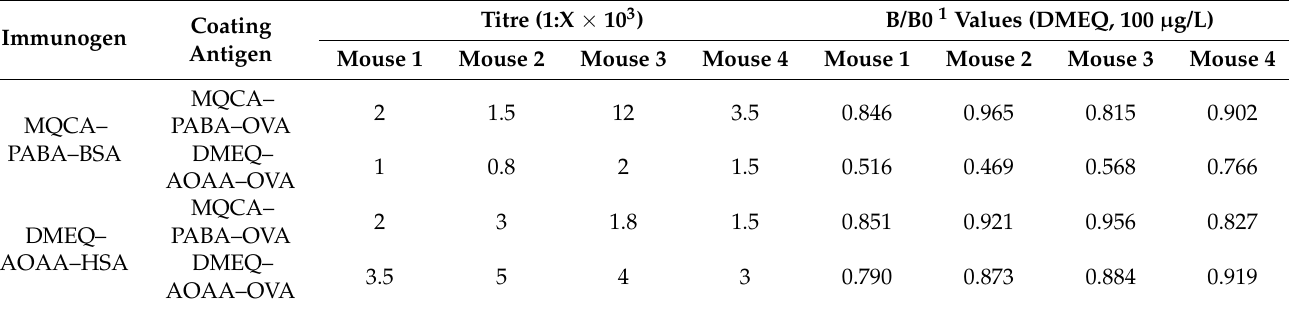
Table 1. The titer and specificity of the antiserum.